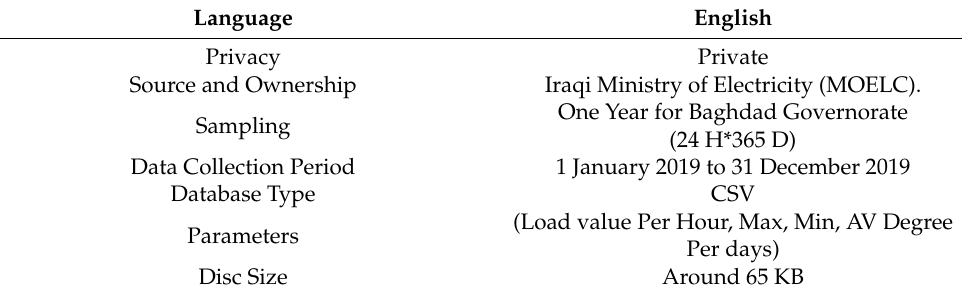
Table 6. Power Load Dataset Profile Information.